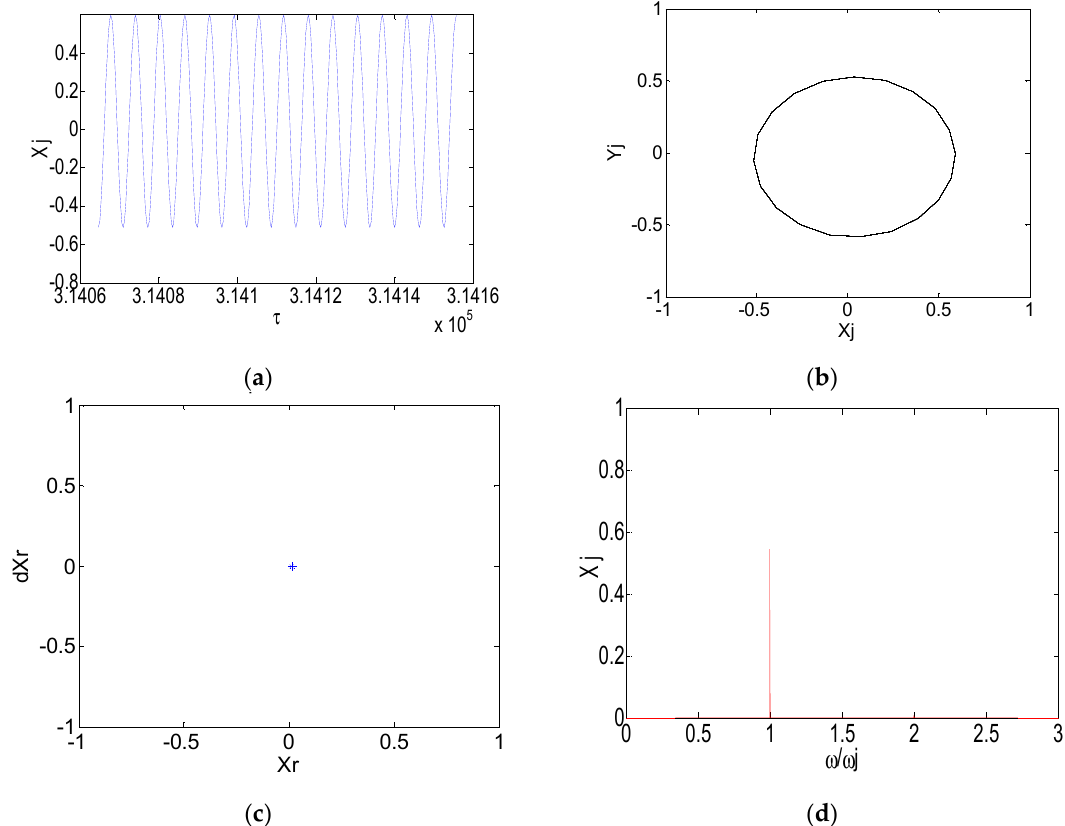
Figure 6. Dynamic response of the floating ring system when λ = 0.01 and speed ratio is S = 1: ( a ) time-domain waveform; ( b ) orbit; ( c ) Poincare section; ( d ) the FFT spectrum of rotor .